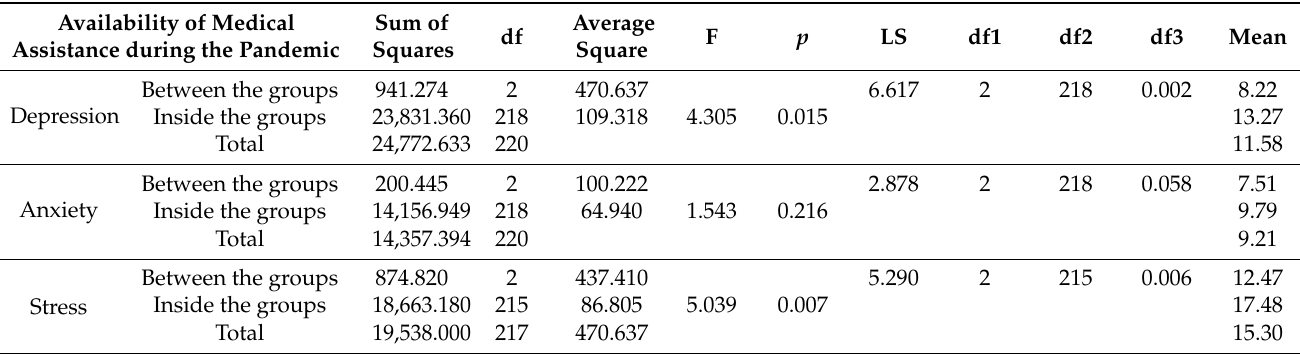
Table 8. Comparison of average values (scores) on the DASS − 21 scale according to the availability of medical assistance during the